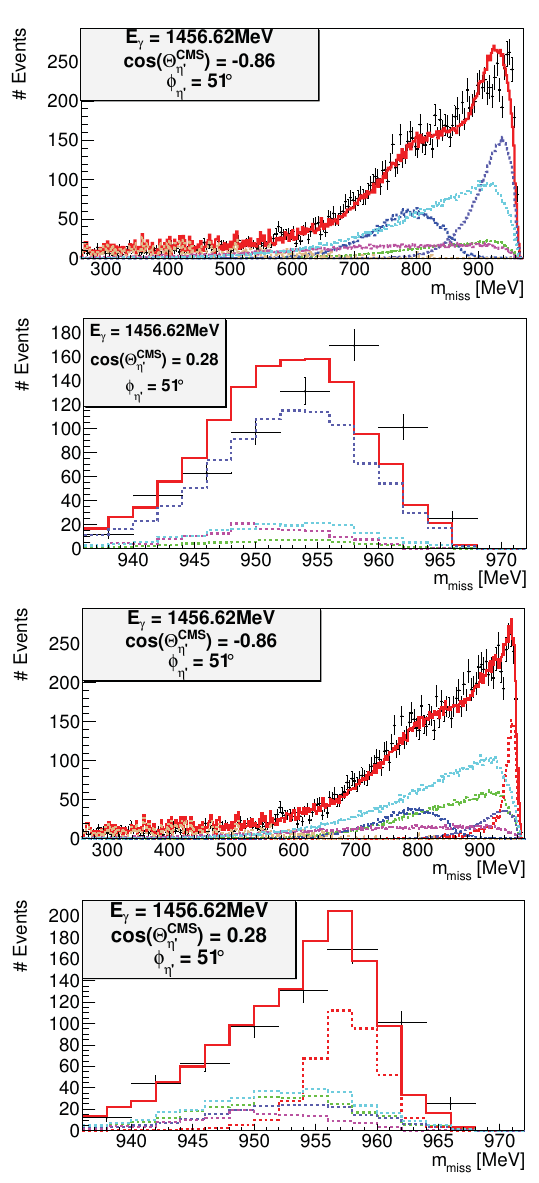
Figure 5. Fits in two di ff erent bins without the η (cid:2) (top two plots) and the same bins with the η (cid:2) included (bottom two plots). The black data points are the real data, the total fit is shown in solid red, the η (cid:2) p contribution in dotted red, 2 π p in purple, 3 π p in light blue, ηπ 0 p in green, ηπ 0 π 0 p in dark purple, ω p in dark blue and π 0 p in brown. Note that ω p and π 0 p only contribute in the most